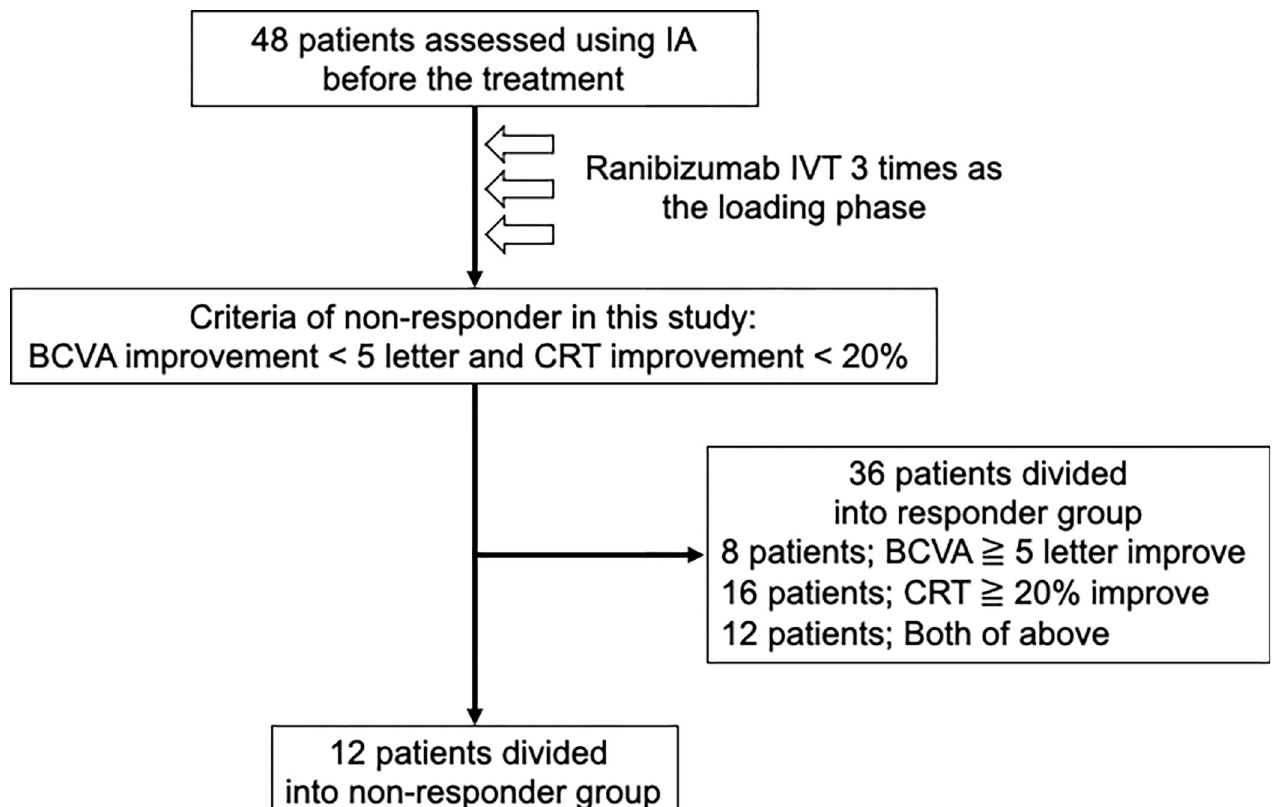
Fig 3. Flow chart. Patients were included in this clinical study, all of whom received ranibizumab IVT.